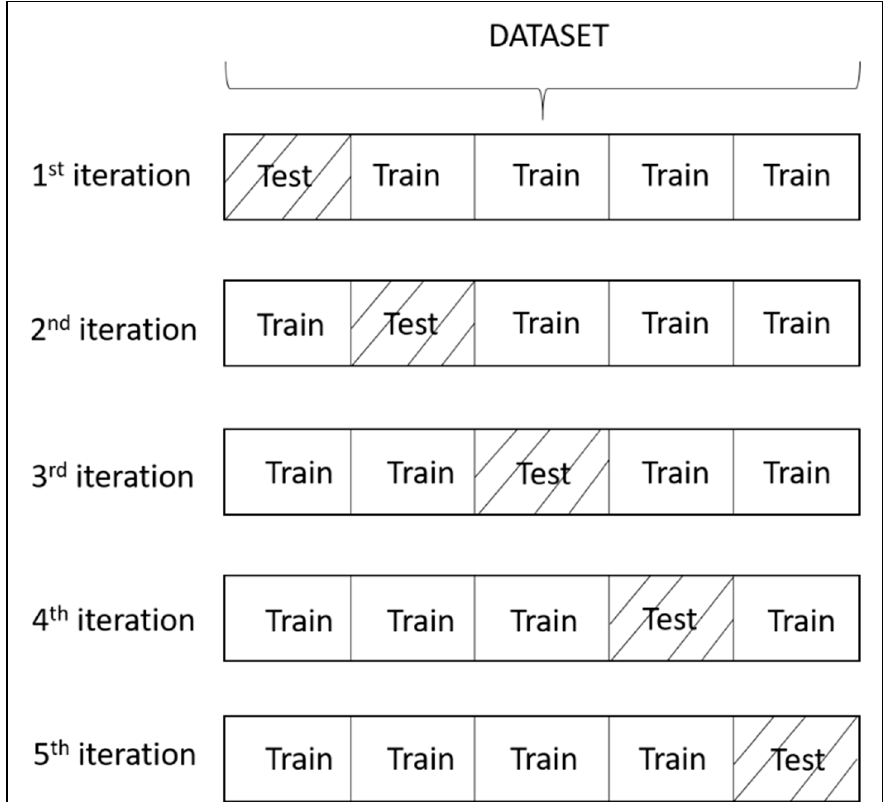
Figure 2. The schematic image of k-fold cross validation (k = 5).